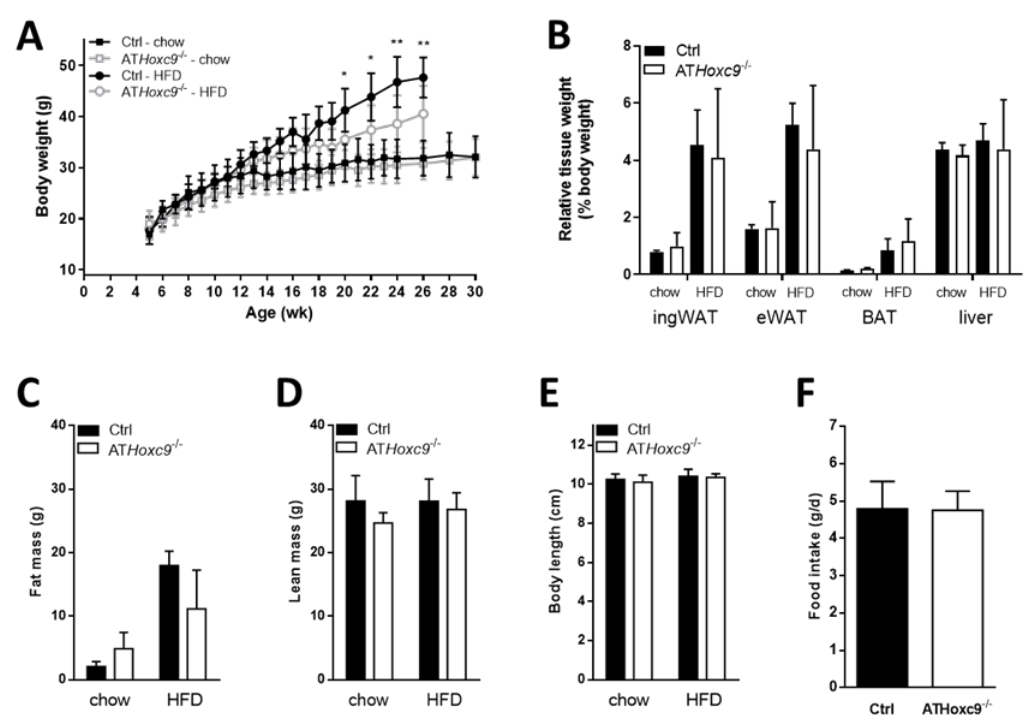
Figure 3. Phenotyping of male AT Hoxc9 deficient mice. ( A – F ) Body weight gain, relative tissue weights, fat and lean mass, as well as body length and food intake do not differ between AT Hoxc9 -/- and control male mice, except body weight differences under high-fat diet (HFD). * p < 0.05, ** p < 0.01. BAT, brown AT.